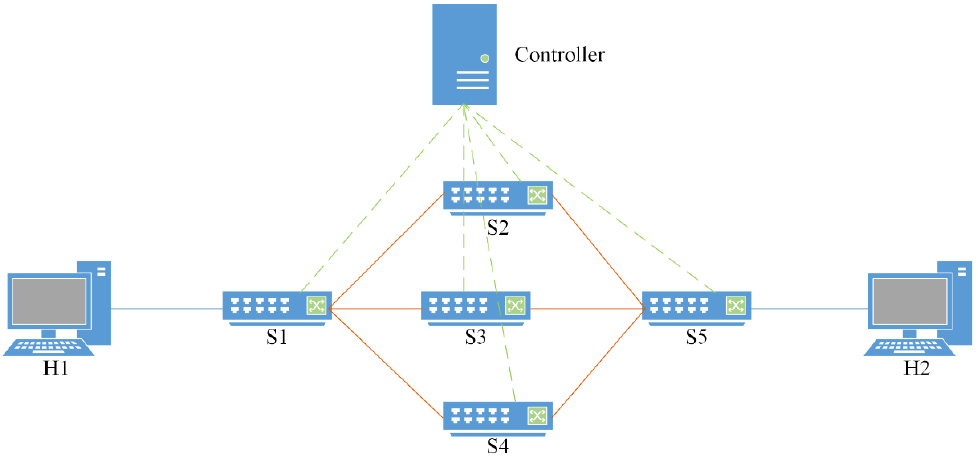
Fig. 3 The network